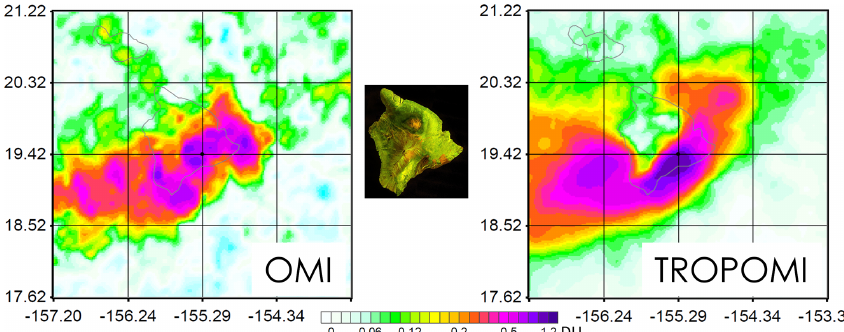
Figure 8. Mean SO 2 (DU) over Kilauea volcano, Hawai‘i, from OMI and TROPOMI data for the period from April 2018 to March 2019. The volcano is in the centre of the map. The influence of orography on the SO 2 distribution is clearly visible due to the high spatial resolution of TROPOMI. A Sentinel-1 image from 23 May 2018 that illustrates the island’s orography is shown in the middle of the